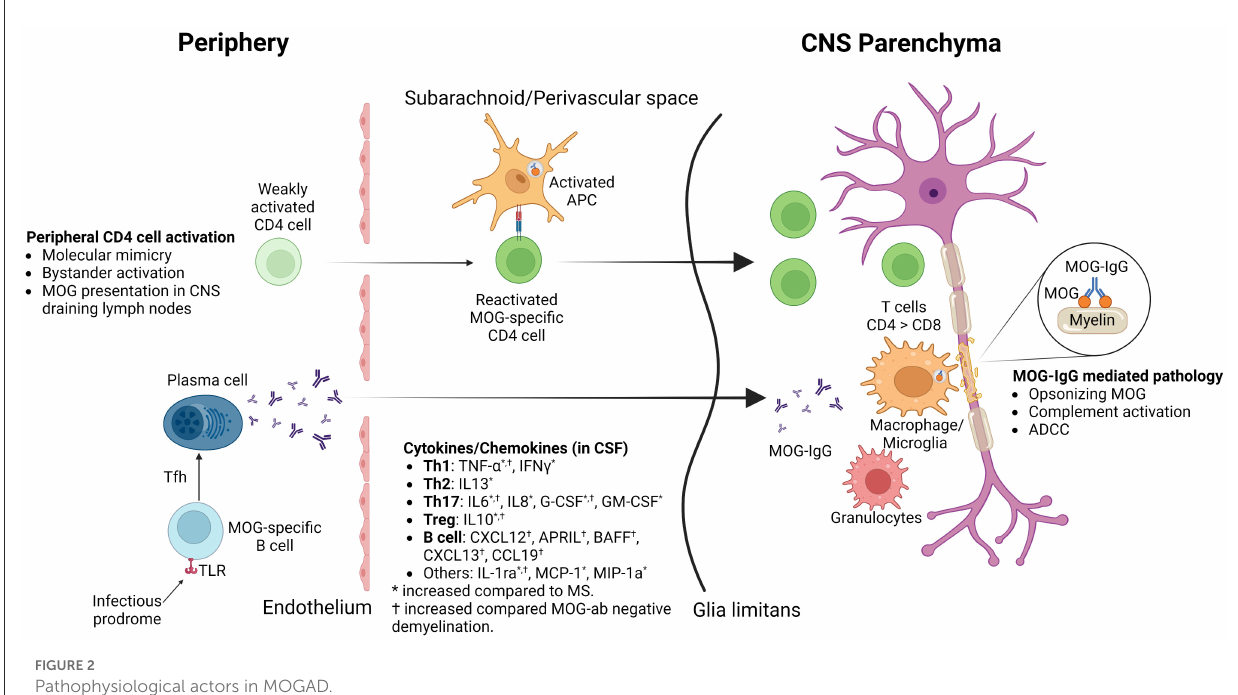
FIGURE2 Pathophysiological actors in